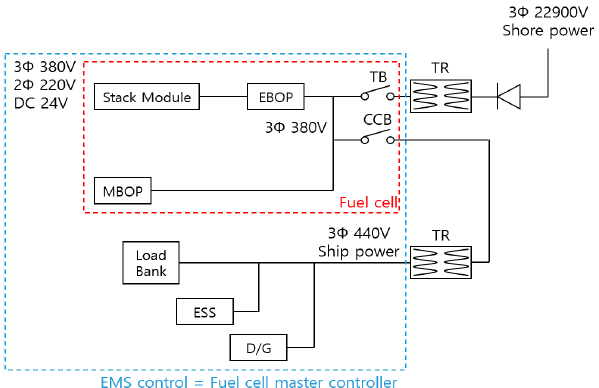
Figure 5. Concept of the fuel cell power